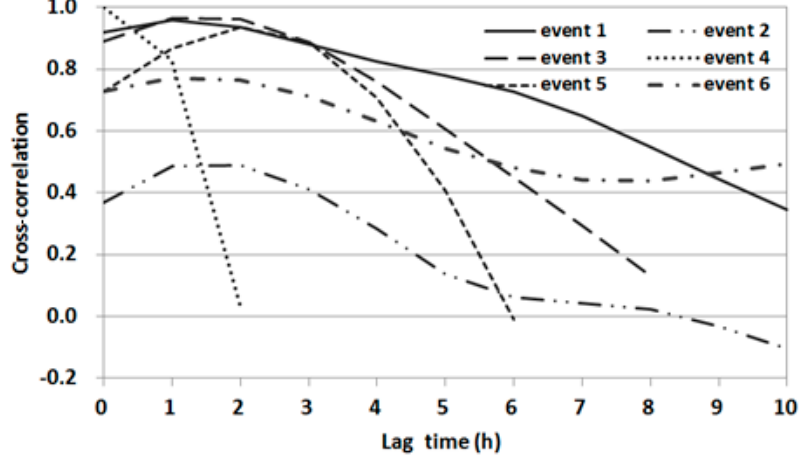
Figure 6. Cross-correlation of water level series between Chunghungyo (CH) and OG.